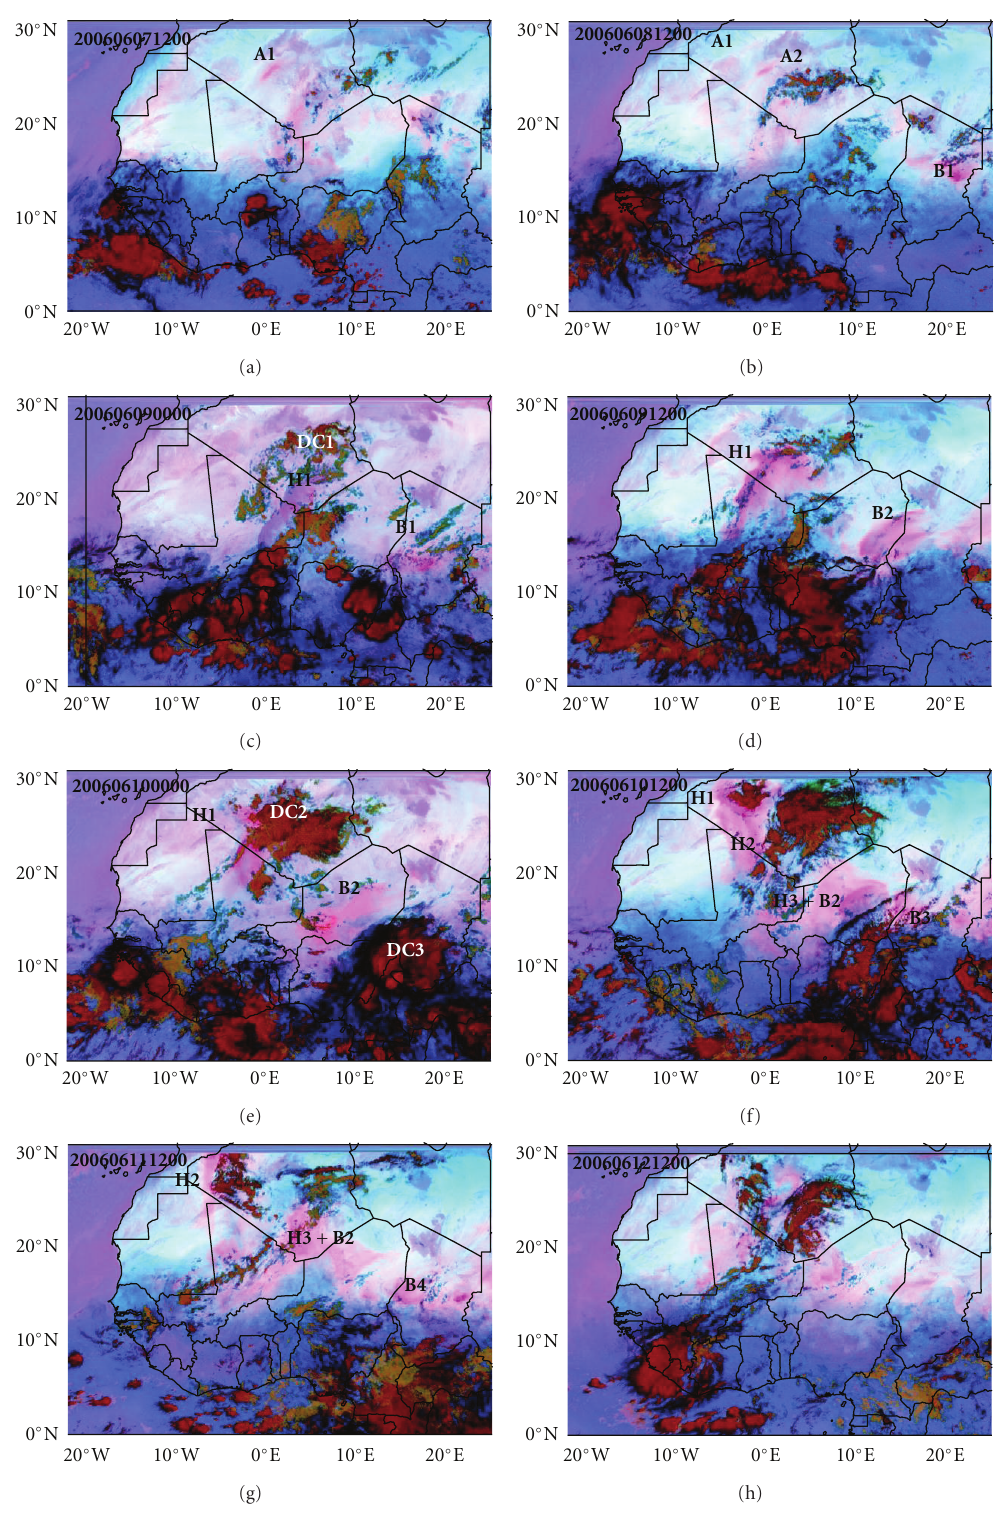
Figure 4: SEVIRI false color dust product imagery at 1200 UTC each day over the study period. Pink tones indicate dust and red-brown- black tones indicate clouds. Letters correspond to major dust and cloud features of interest (see text for